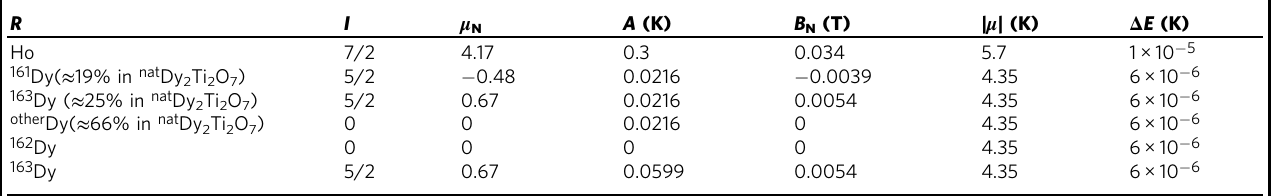
Table 1 Hyper fi ne properties of the used materials R 2 Ti 2 O 7 ( R = Ho, Dy)